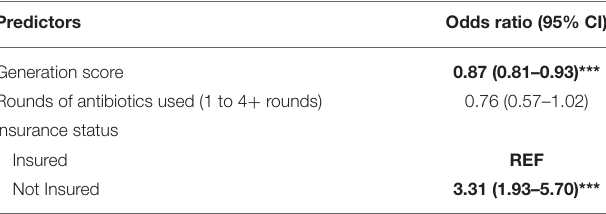
TABLE 4 | Multivariable logistic regression: odds of preferentially sourcing antibiotics from